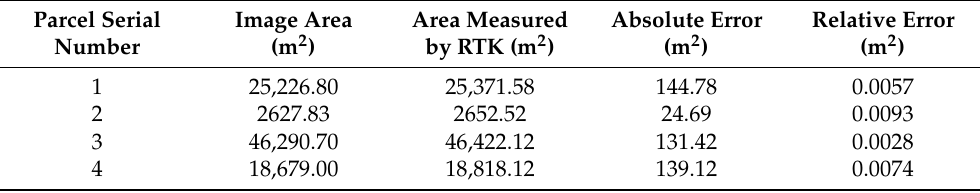
Table 3. Error analysis of the actual measured plot area and remote sensing image area.